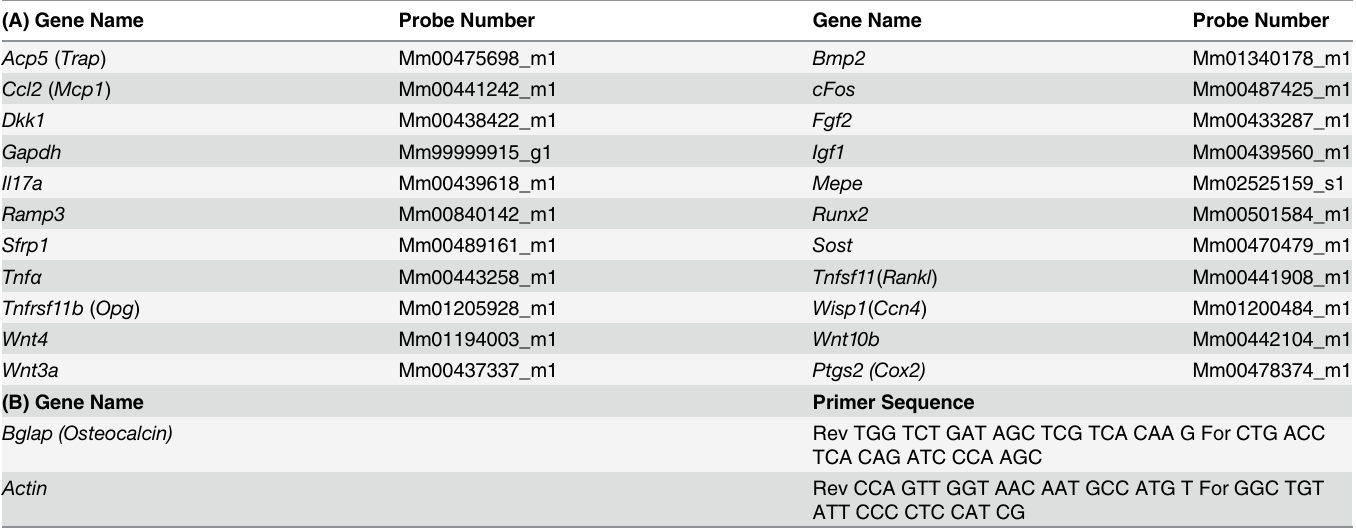
Table 1. List of genes and primers used to analyze gene expression by quantitative real time PCR.